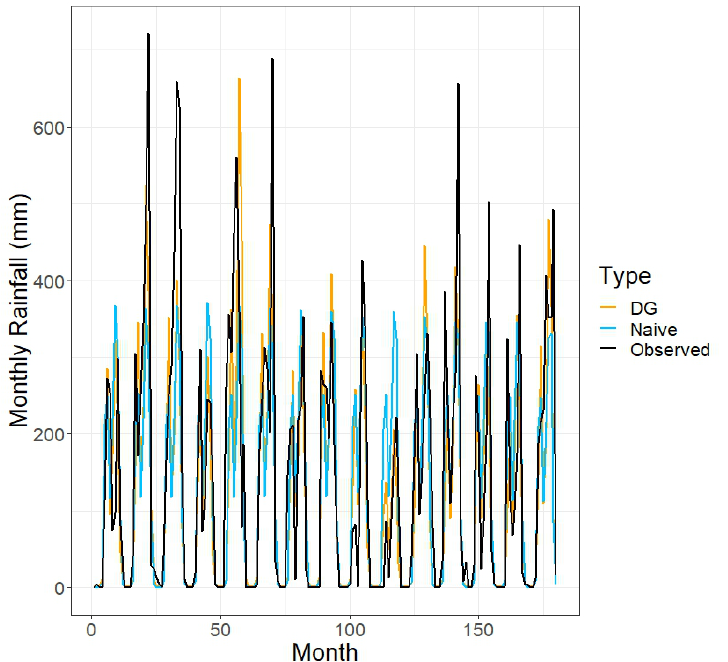
Figure 6. One-month-ahead predicted (using the double Gaussian and naive approaches) and observed monthly rainfall values at the Liberia station from 2006 to 2020. “Month” is the number of months since January